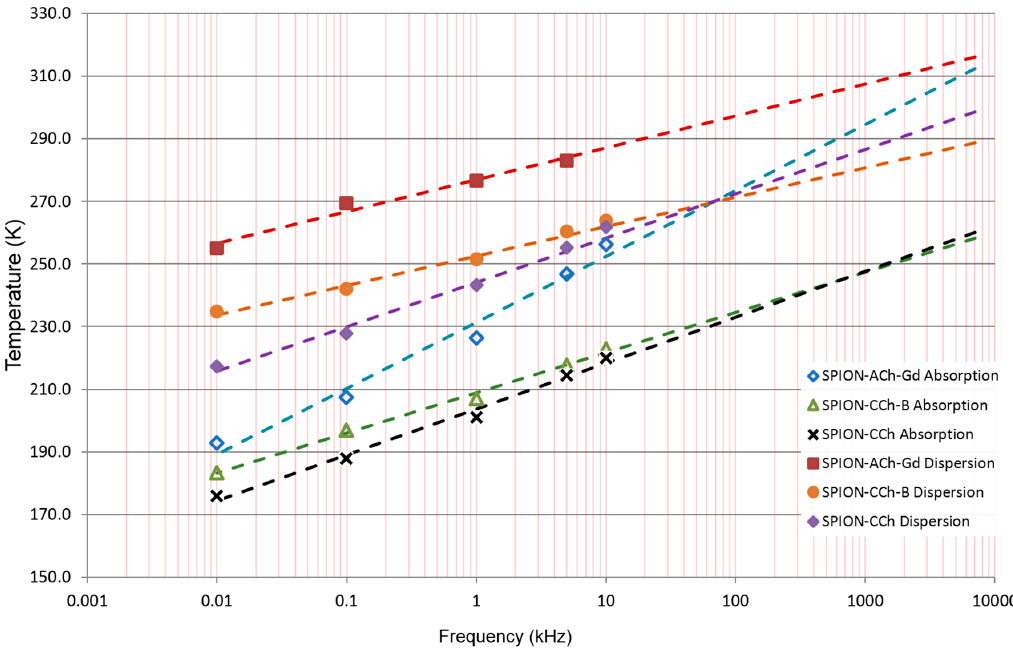
Figure 6. Temperatures at which the susceptibility maximum occurs as a function of the excitation frequency for the absorption (open symbols) and dispersion (full symbols) parts and their linear extrapolation to higher frequencies for an exciting field of 10 Oe. Table 4. Frequency corresponding to the maximum susceptibility extrapolated to 312